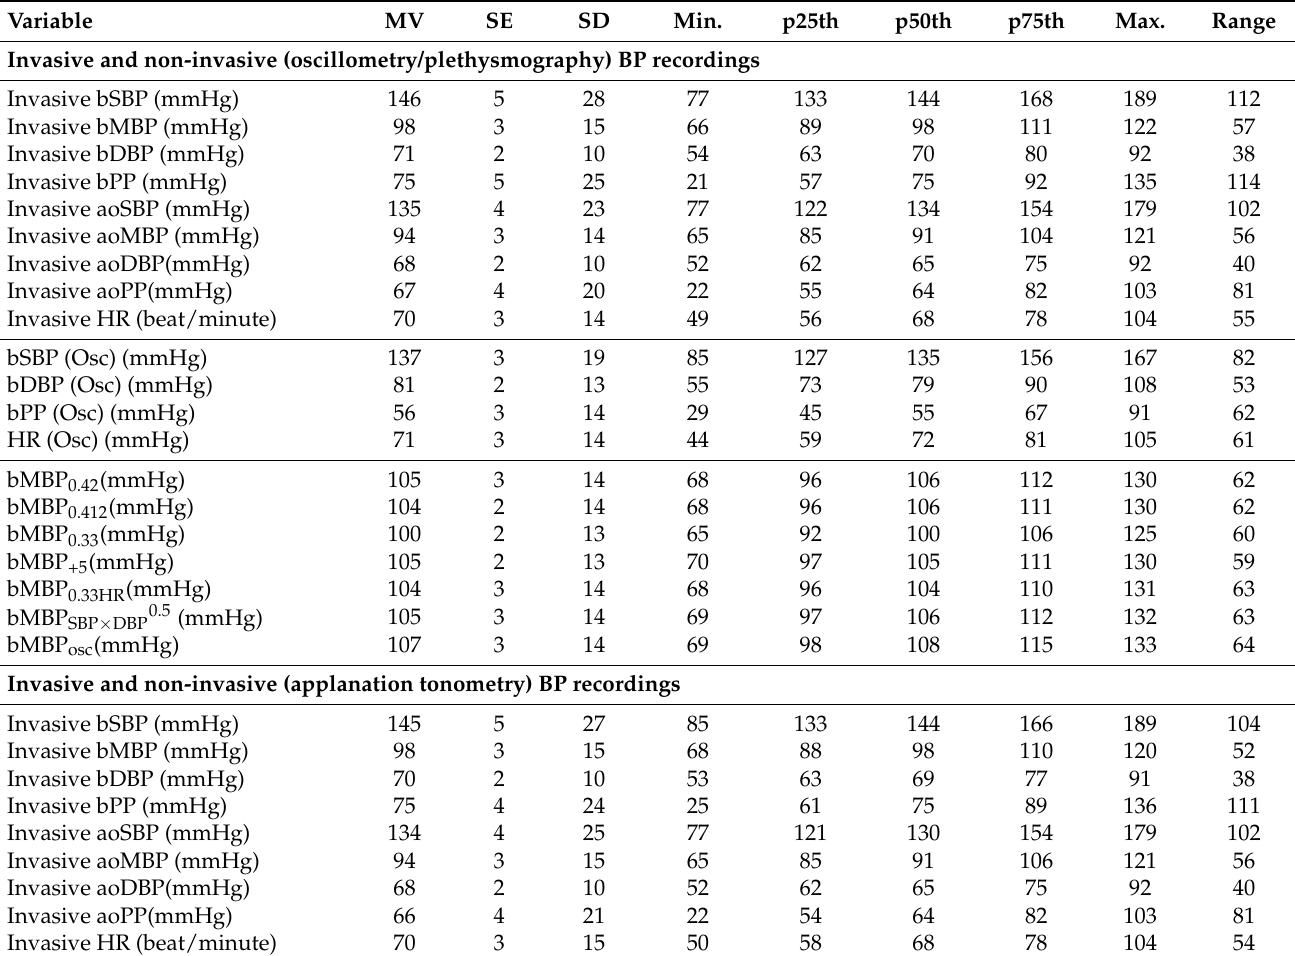
Table 2. Invasive and non-invasive aortic and brachial blood pressure